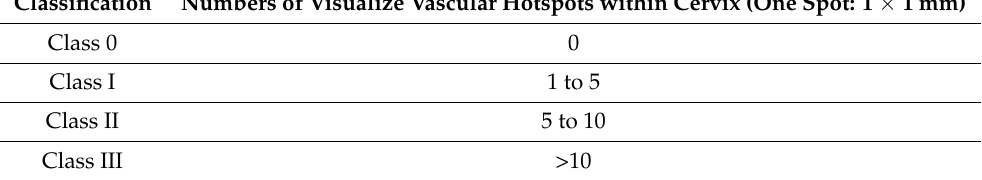
Table 2. Visualize vascular hotspot classification system.